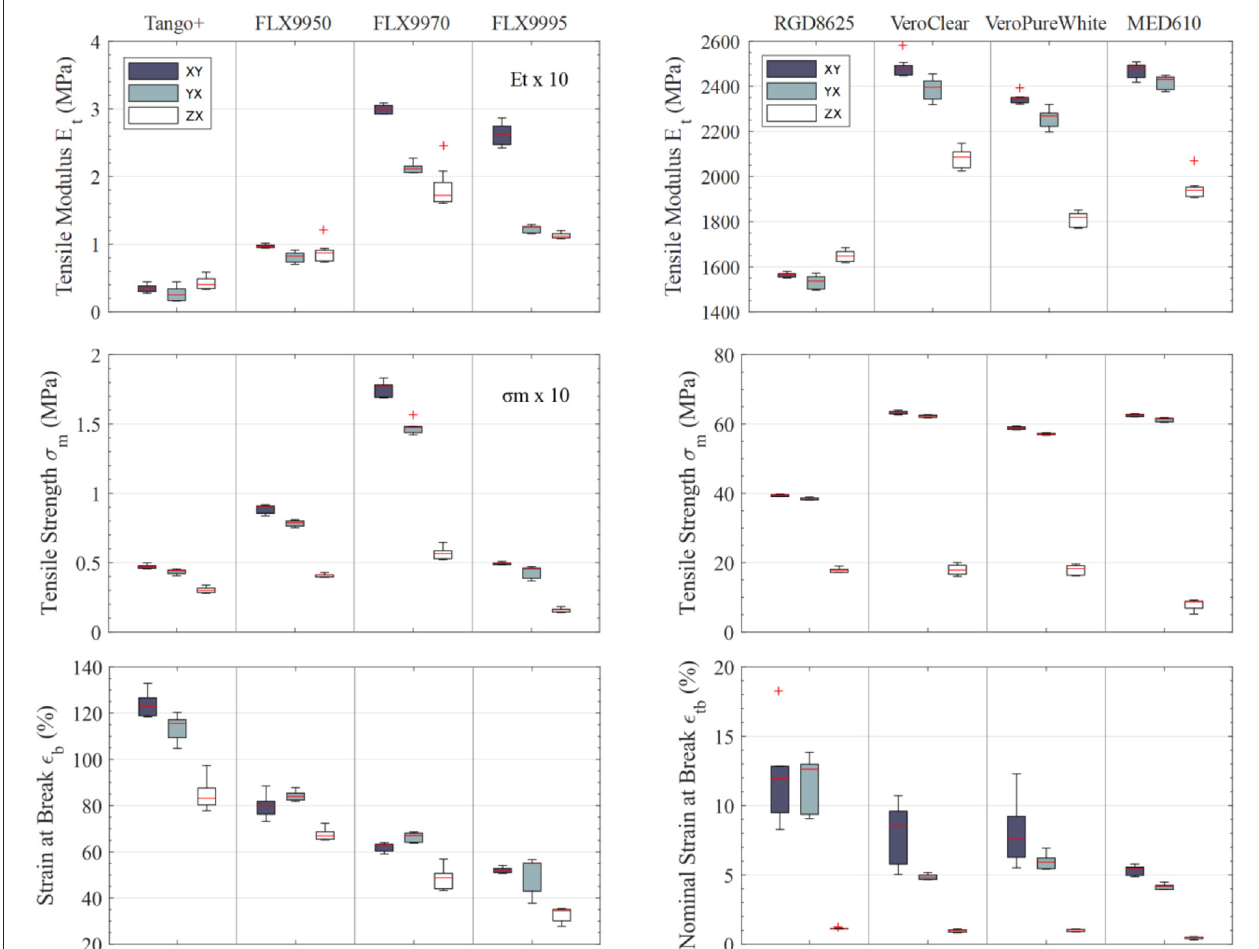
FIGURE 5 | Boxplots of the mechanical data of all tested materials at different orientation levels ( n = 6 for each of the three orientation levels and for each material). Red bars within the interquartile range delimited by the box itself show the median value; outliers are shown as red + signs.